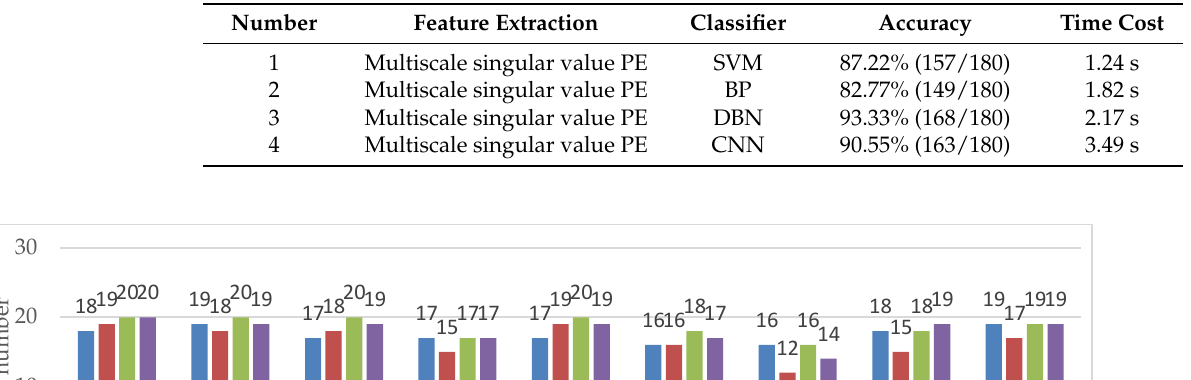
Table 3. Comparison of accuracy of different classification methods.